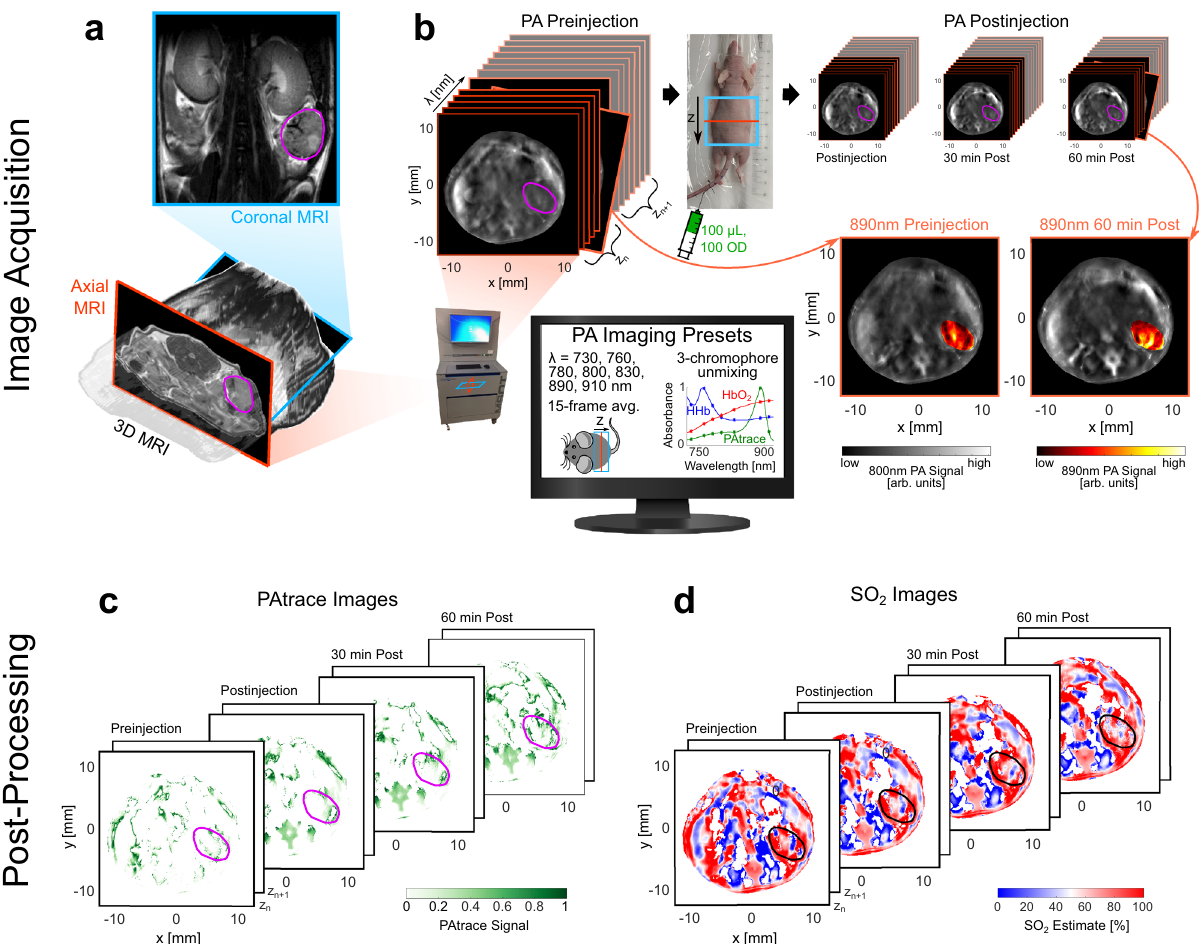
Fig. 5 Summary of methods for in vivo PA imaging study. a Coronal (top) and axial (bottom) MR images to monitor tumor growth, and 3D (bottom) MRI data to localize ovarian tumors in PA images. b PA imaging work fl ow: mice placed in the inVision system (bottom-left), and system set to PA imaging presets (i.e., wavelengths, averaging; bottom-left). Preinjection (top-left) PA axial images (800 nm shown) were acquired for each wavelength at z-positions encompassing the liver, spleen, kidney, and tumor. 100 µ L of either targeted FR α -PAtrace or non-targeted RG-16-PAtrace (100 OD) was injected intravenously; photograph (top-middle) of mouse setup for intravenous PAtrace injection with a blue box showing PA scan length and orange line indicating current axial slice. Postinjection (top-right) imaging was performed at three time-points, allowing for slice-by-slice co-registration. Representative 800 nm (grayscale colormap) anatomical image with overlaid 890 nm (hot colormap) PA images of the matched tumoral cross-section are shown preinjection (bottom-middle) and 60 min postinjection (bottom-right) to visualize signal enhancement after PAtrace has accumulated. Images were fl uence corrected and linearly unmixed for c PAtrace and d hemoglobin (to obtain SO 2 ) for each z-position and